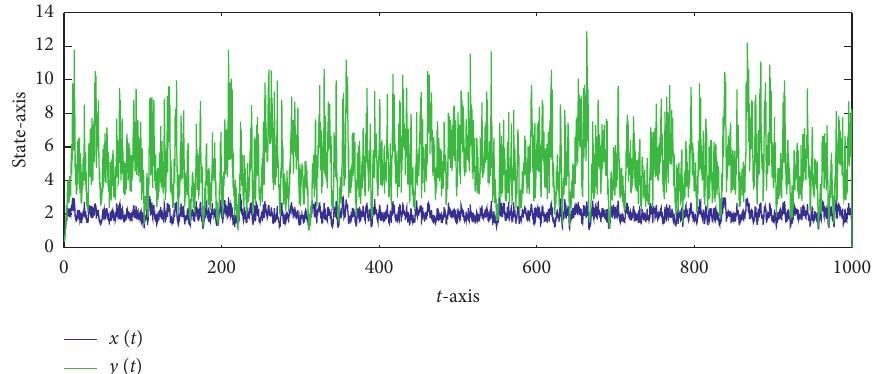
Figure 5: The stochastic permanence of (39) and (40) with π � ( 0 . 4 , 0 . 6 )